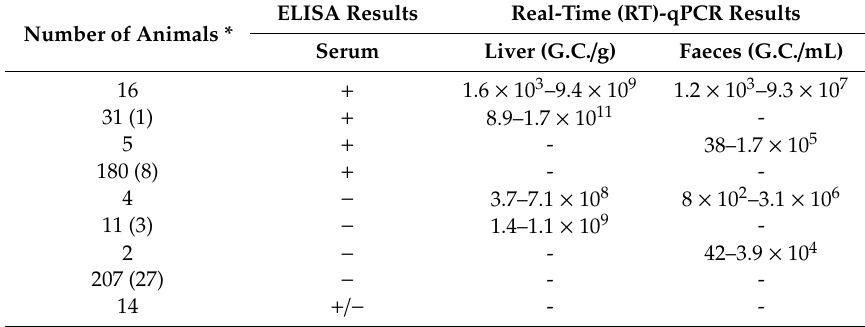
Table 3. Results of molecular and quantitative analysis of liver and faeces of wild